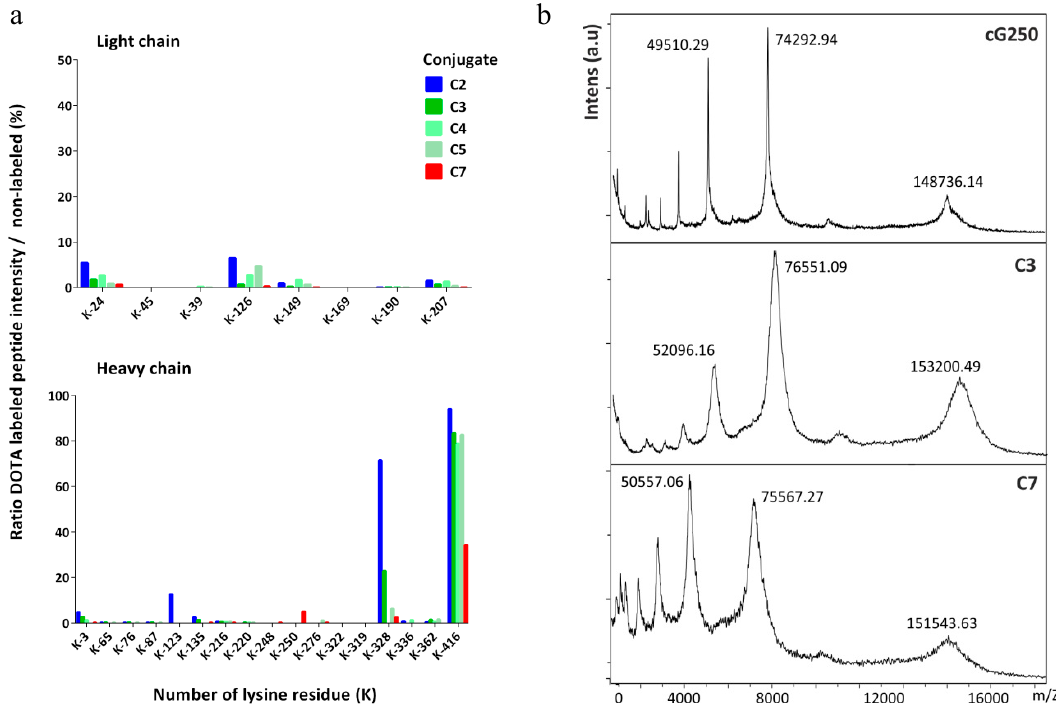
Figure 2. Characterization of the DOTA(SCN)-cG250 conjugates by mass spectrometry: ( a ) Lysine occupancy in the LC (top) and HC of DOTA(SCN)-cG250 post trypsin in-gel digestion of the proteins ( n = 3) in conjugate C2 (90 min), C3, C4, C5 (60 min), and C7 (30 min) and ( b ) mass measurements by MALDI-TOF MS of native cG250 and conjugates C3 and C7.